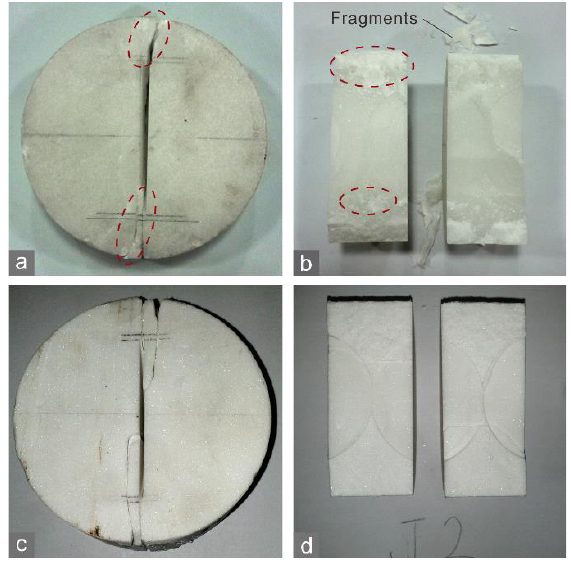
Figure 5. Crack morphologies of ( a , b ) marble A and ( c , d ) J. The red dashed ellipses in ( a ) denote white patches around the notched crack tips.